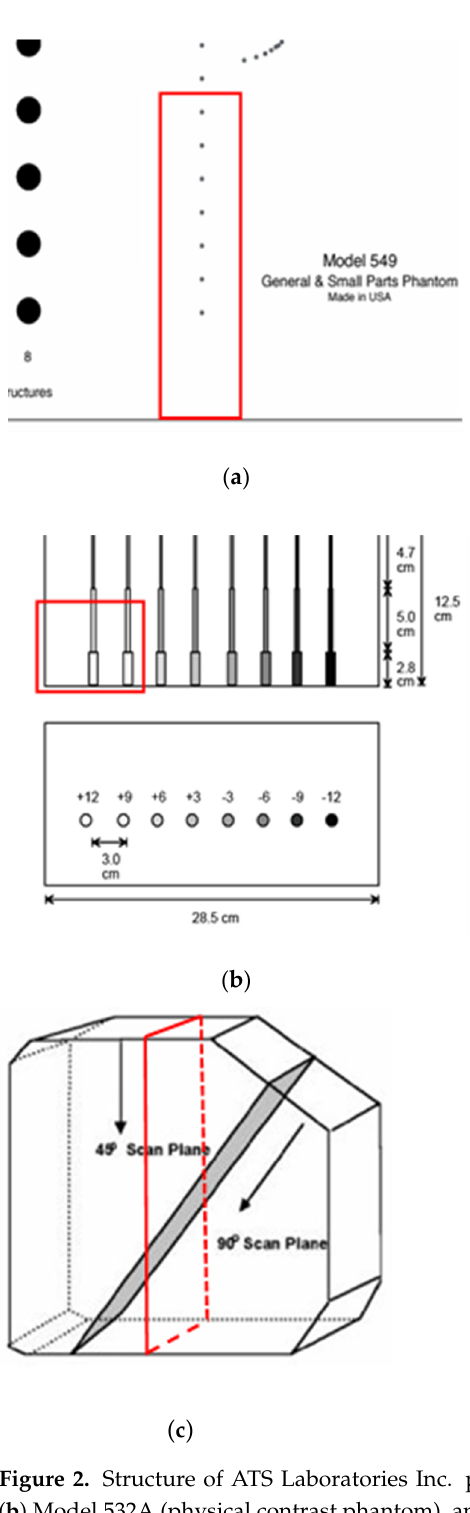
Figure 2. Structure of ATS Laboratories Inc. phantoms ( a ) Model 549 (physical wire phantom), ( b ) Model 532A (physical contrast phantom), and ( c ) Model 538NH (slice thickness phantom) with preselected scanning areas shown. Adopted from [38–40].